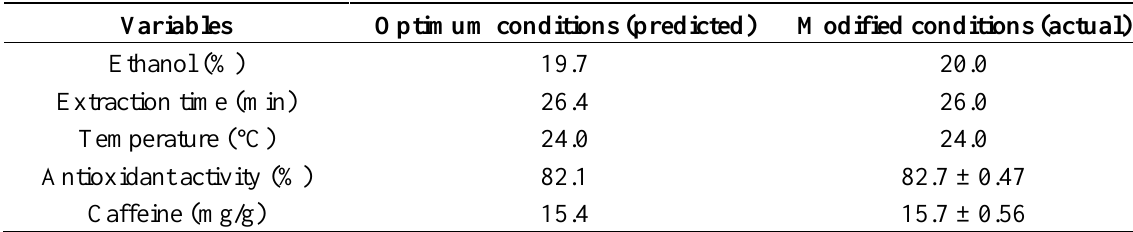
Table 4. Optimum conditions and the predicted and experimental value of responses at the optimum